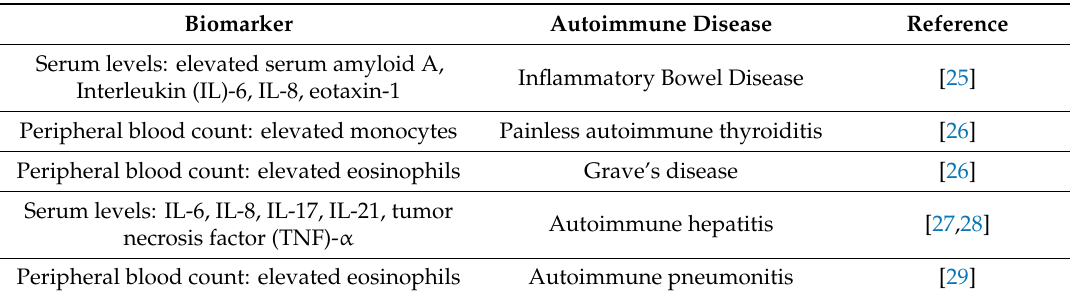
Table 3. Biomarkers for monitoring immune activation in inflammatory and autoimmune